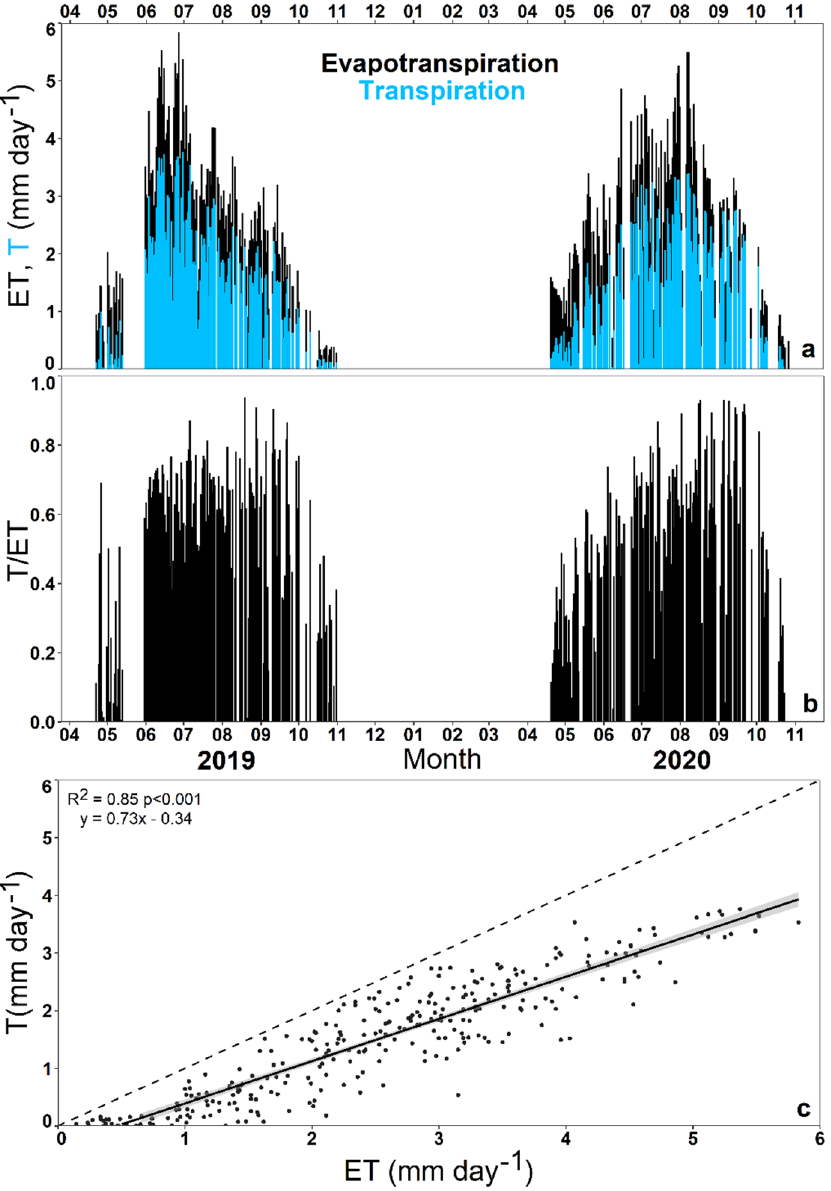
Figure 2. Dynamics of ecosystem transpiration and evapotranspiration daily sums ( a ) and transpiration to evapotranspiration ratio ( b ) during the 2019–2020 period. Relationship between daily ecosystem transpiration and evapotranspiration rates ( c ). Table 2. Results of one-way ANOVA for statistical differences of transpiration, evapotranspiration, and transpiration to evapotranspiration ratio between the months.